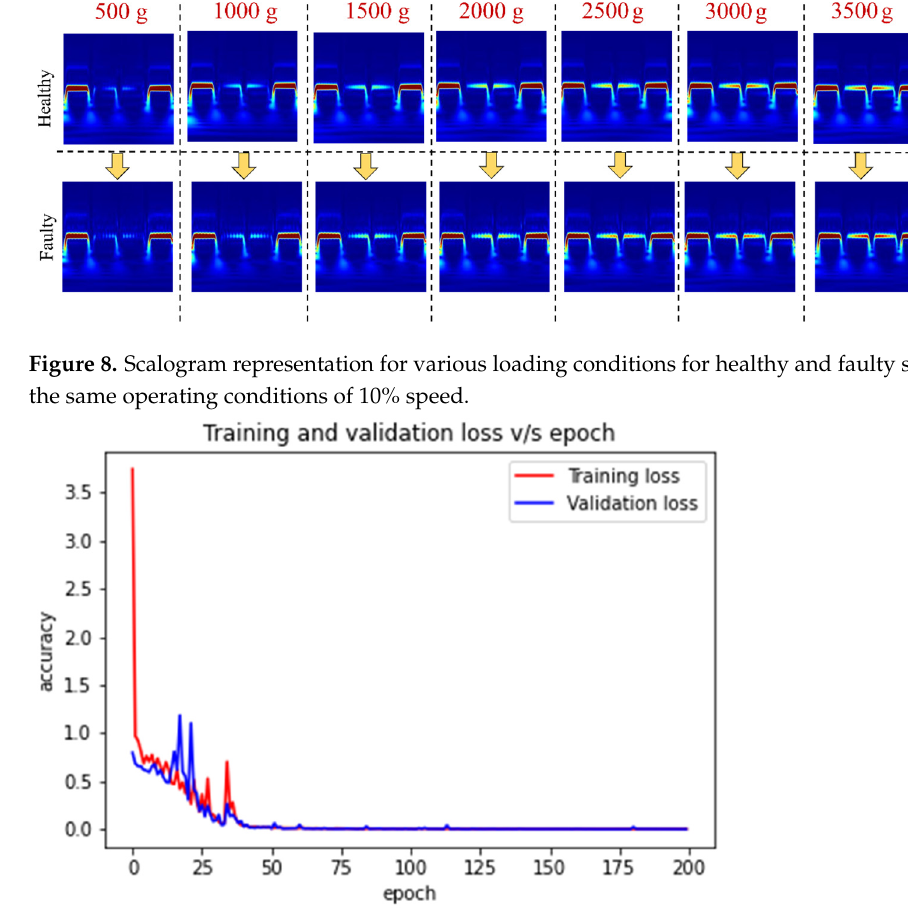
Figure 9. The proposed TL-based FDD approach’s loss curve using simple motion data.